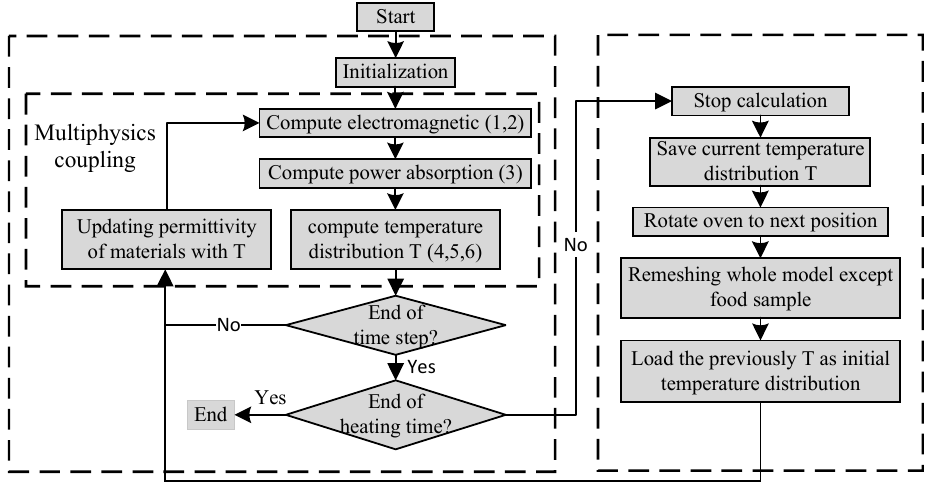
Figure 1. Overall flowchart of the proposed method.